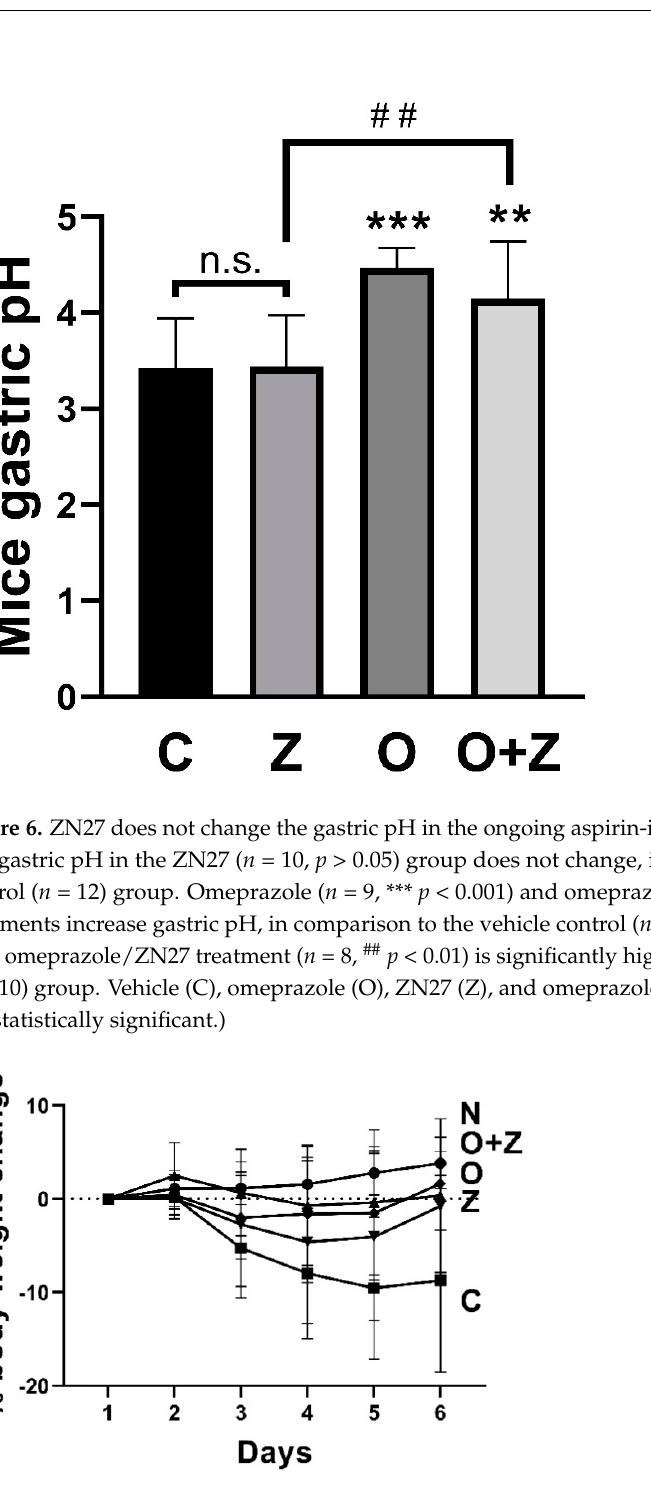
Figure 7. ZN27 treatment accentuates the weight loss associated with the ongoing aspirin-induced gastric injury. Y-coordinate indicates the percentage of the body weight change. The vehicle control group lost substantial weight. ( n = 13) However, the changes in the omeprazole-treated group ( n = 9), ZN27-treated ( n = 18), and omeprazole/ZN27-treated ( n = 8) groups were not significant, in comparison to the normal ( n = 9) group (uninjured, untreated) by the end of the study. There were also no significant differences among the omeprazole, ZN27, and omeprazole/ZN27 groups. Normal (N), vehicle (C), omeprazole (O), ZN27 (Z), and omeprazole/ZN27 (O + Z).